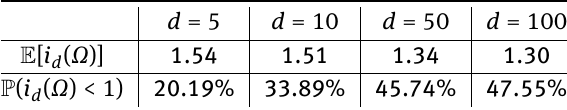
Table 2: Mean of the probability distribution of i d ( Ω ) and probability of underweighting outer leaves, with Ω ∼ U ( C d ) based on n = 1, 000, 000 simulations, for d ∈ { 5, 10, 50, 100 }